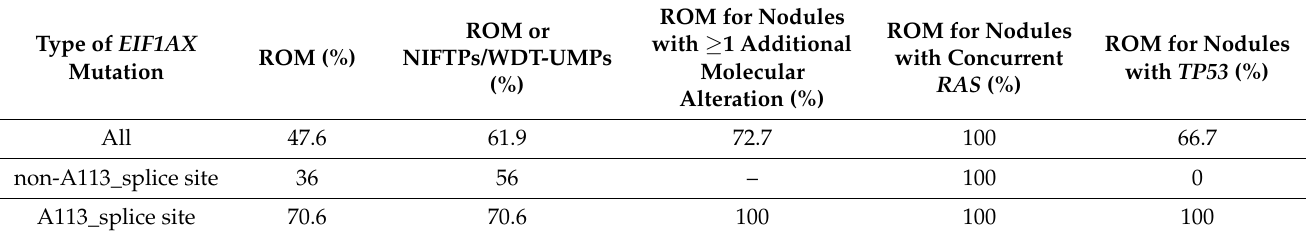
Table 2. ROMs for non-A113_spice site and A113_spilce site